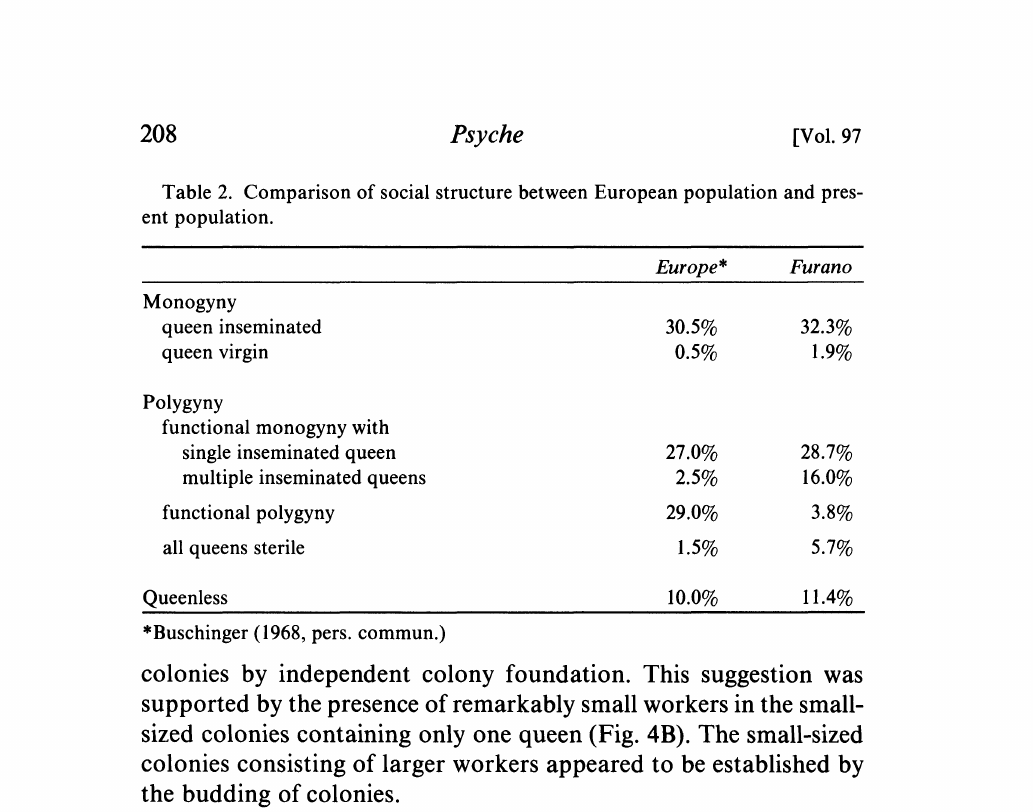
Table 2. Comparison of social structure between European population and pres- ent